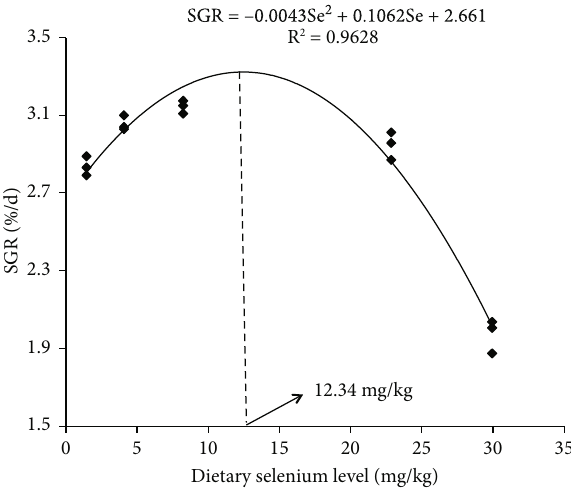
Figure 1: Relationship between speci fi c growth rate (SGR) and dietary selenium (Se) concentrations for juvenile triangular bream ( Megalobrama terminalis ) fed the test diets for 8 weeks. The regression equation was described as SGR = – 0 : 0043Se 2 + 0 : 1062 Se + 2 : 661 ( r 2 = 0 : 9628 , n = 3 , P < 0 : 05